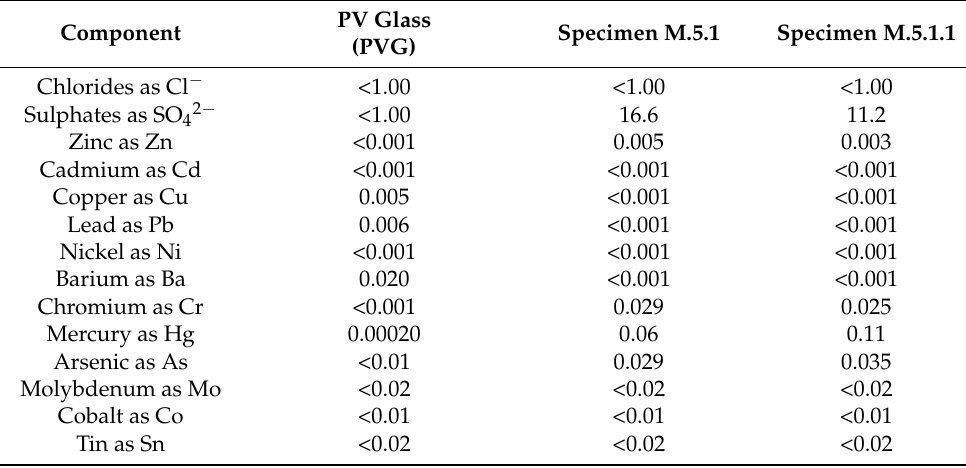
Table 6. Water extract of selected components of mixtures, in mg/dm 3 .